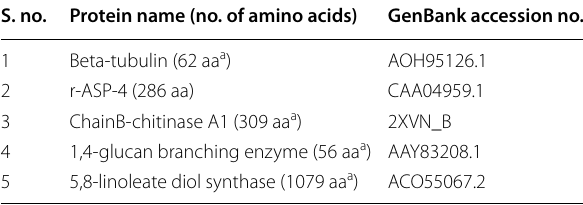
Table 1 Proteins of A. fumigatus with accession number